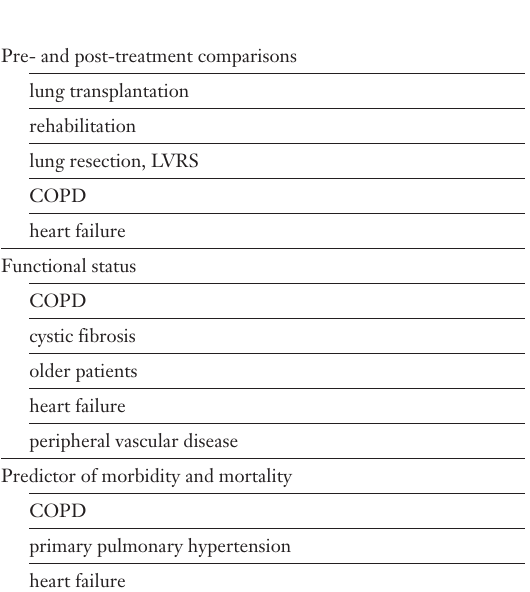
Table 2 Minimal require- ments for a 6MWT (adapted from reference [17]).